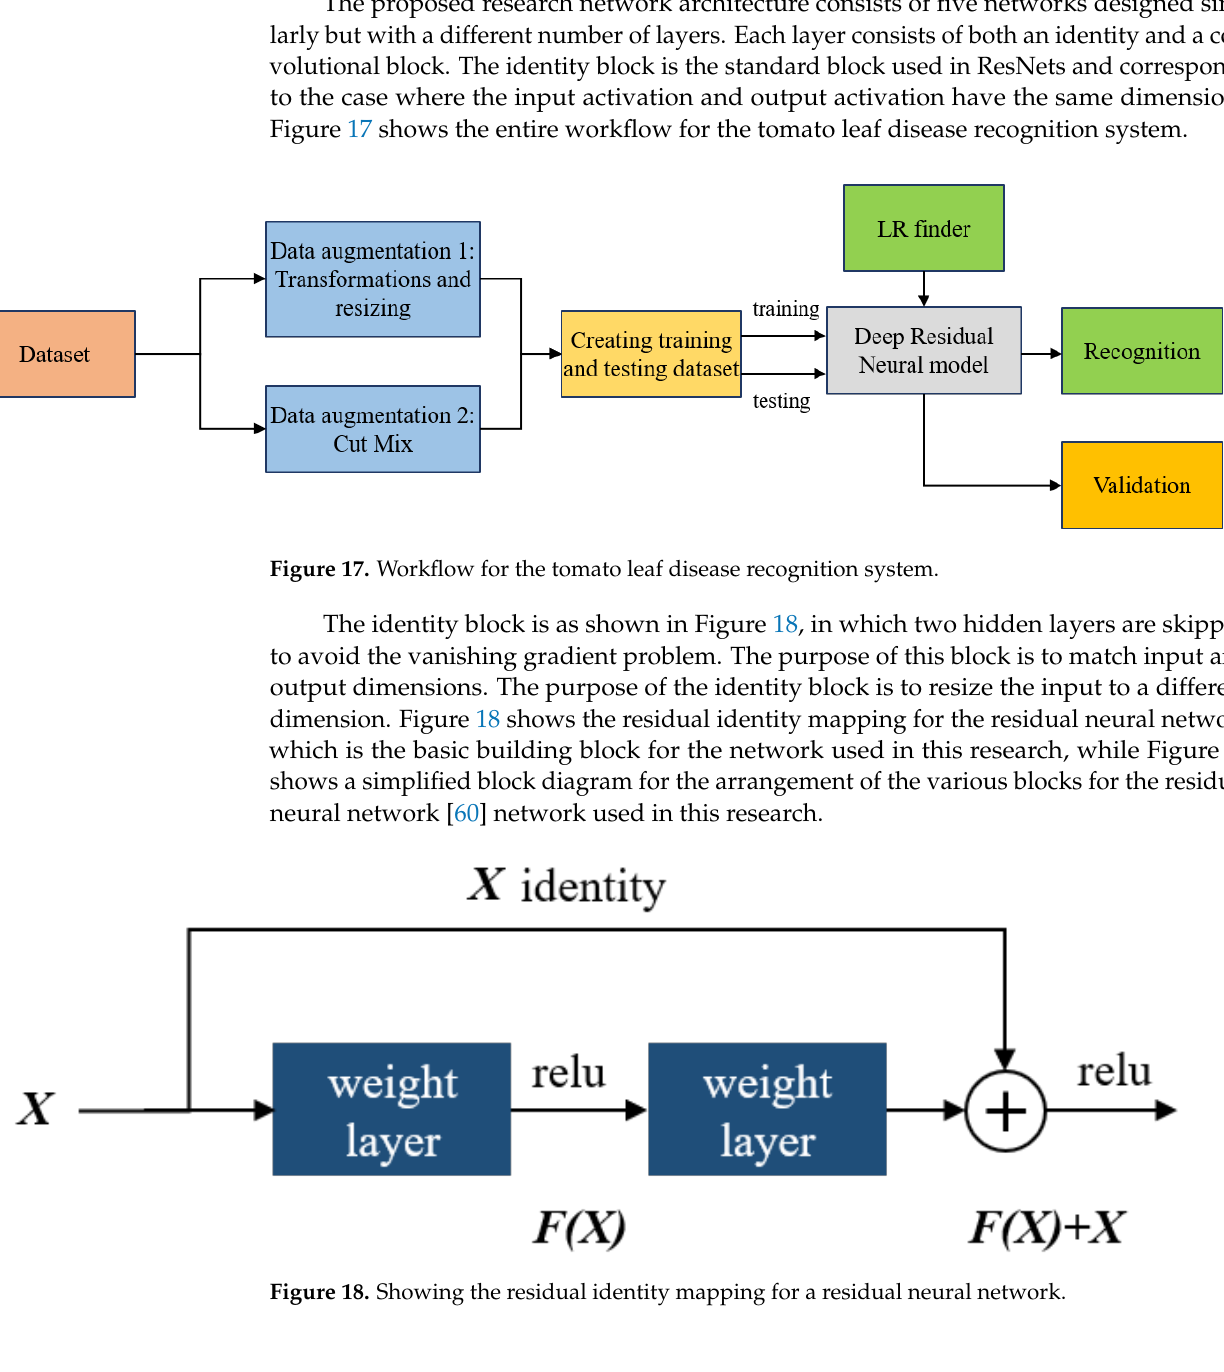
Figure 19. Simplified block diagram for the residual neural network. Training deep learning architectures, whether it is a new model from scratch or via transfer learning is not without its difficulties. Learning algorithms based on artificial neu- ral networks, and particularly deep learning for computer vision, may appear to include a plethora of bells and whistles, popularly known as hyperparameters [85]. To success- fully train and debug them, more hyperparameters should be adjustable, and this has made it possible for one to obtain more interesting results. Making sure we have the right learning rate is one of the most important things we can do when training a model. If our learning rate is too low, training our model may take many, many epochs. For this re- search, all our five networks were pre-trained with the ImageNet dataset and then fine- tuned in the manner described below for re-training on our tomato leaf images. We implement discriminative learning rates [86] in the process of training our model on plant leaf images. Discriminative fine-tuning is a fine-tuning strategy introduced by universal language model fine-tuning (ULMFiT) [86] for the implementation of natural language processing (NLP). Instead of the same learning rate being used across all the layers of our model, this allows us to tune each layer with a different learning rate that is efficient and suits it better than any other learning rate. Since the deepest layers of pre- trained models may not require so high a learning rate as the final ones will require, we will use different learning rates for them as described by [84,87]. To preserve the quality of those pre-trained weights even after unfreezing them, some of the added parameters are tuned for a few epochs, and naturally, we would not expect the best learning rate for those pre-trained parameters to be as high as the best learning rate for the randomly added parameters. Keep in mind that the pre-trained weights were trained on millions of images over hundreds of epochs, so they have learned